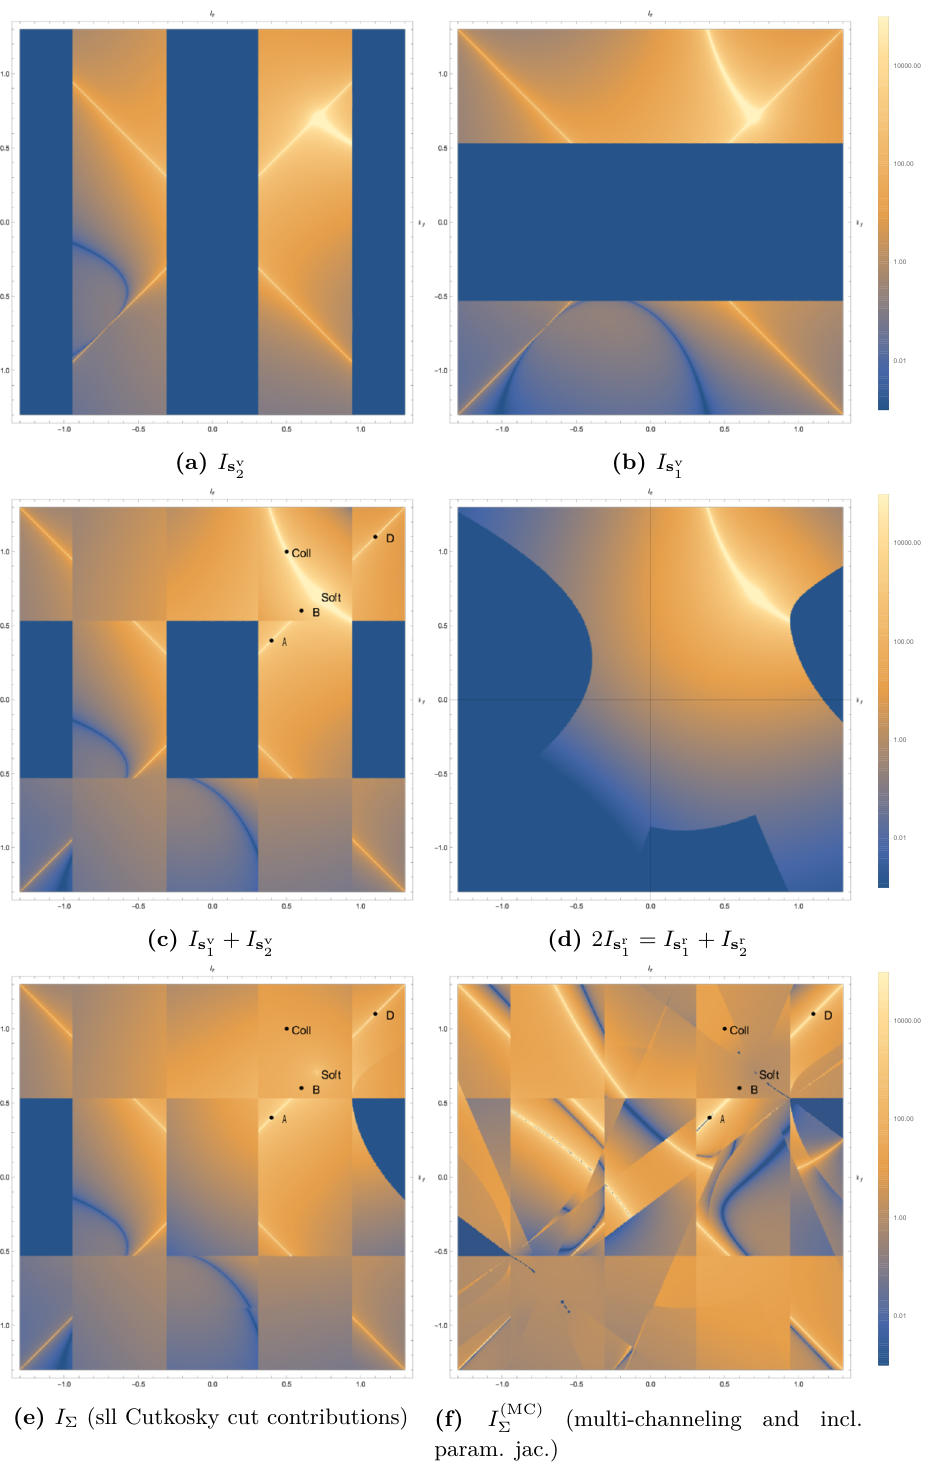
Figure 13. Absolute value of the Local Unitarity integrand from α Loop evaluated at ( ~k,~l ) = ((0 , k ) , (0 , 1 √ 1 √ , l z )) for the semi-inclusive cross-section of the DT supergraph and various com- y , 2 2 bination of Cutkoksy cuts and with no contour deformation. The log scale has been capped within the range [10 − 3 , 10 5 ]